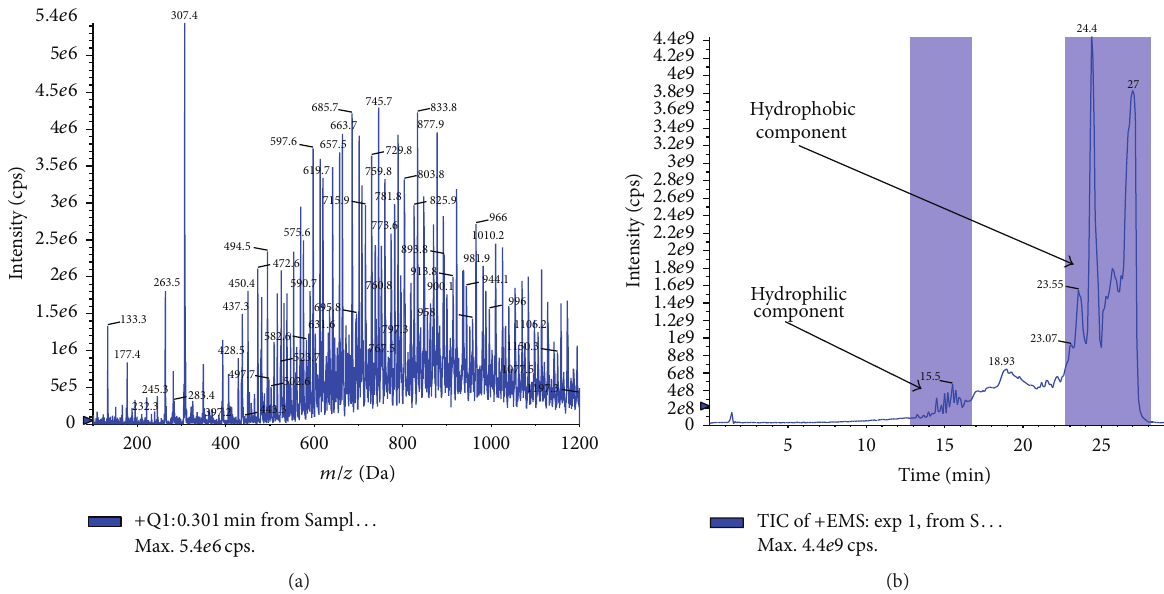
Figure 2: (a) Parent ion (full scan) scan of CrEL. (b) Chromatogram representing the difference in elution pattern of hydrophobic and hydrophilic oligomers of CrEL.